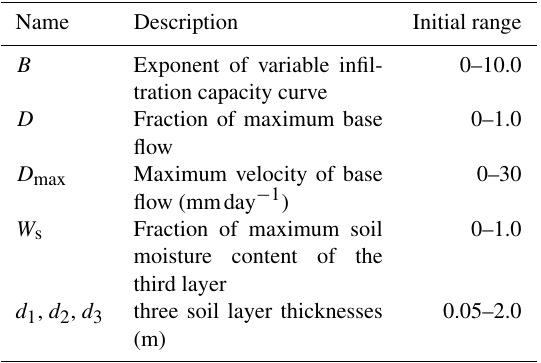
Table 3. Parameter values for the VIC model. Table 4. Parameters of BTOPMC